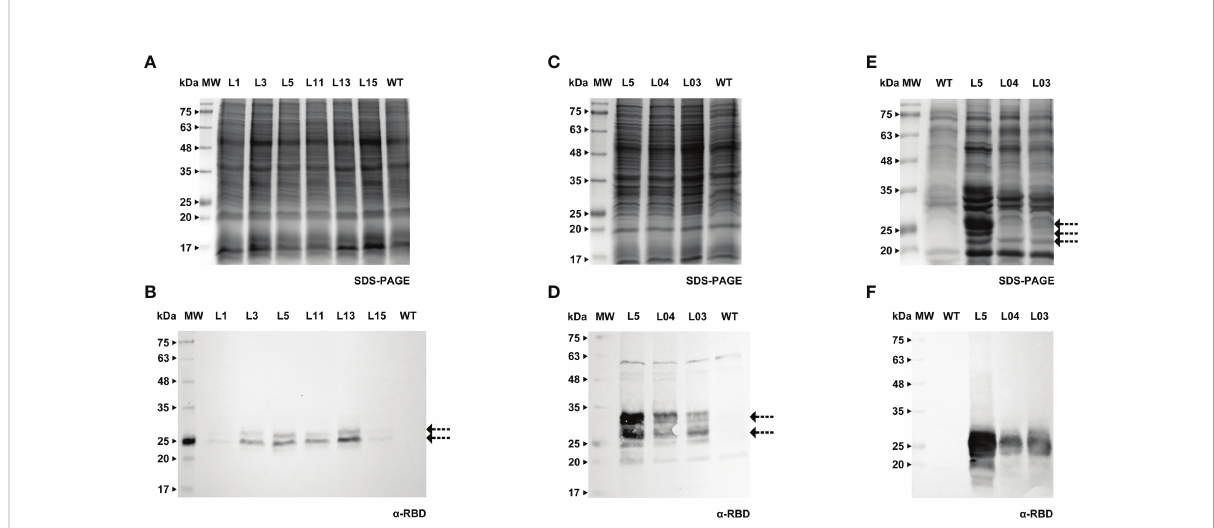
FIGURE 4 Detection of RBD in calli (A, B) , cell extracts (C, D) and spent medium (E, F) of Medicago. (A) Stained gel containing total protein extract of six calli of Medicago, WT - wild type. (B) Corresponding WB with anti-RBD antibody. (C) Stained gel containing cellular extract of three independent Medicago cell lines, WT - wild type. (D) Corresponding WB with anti-RBD antibody. (E) Stained gel containing spent medium of three independent Medicago cell lines, WT - wild type. Samples were concentrated with ice-cold ethanol (L5 - 10x, L04 and L03 - 20x). (F) Corresponding WB with anti-RBD antibody.